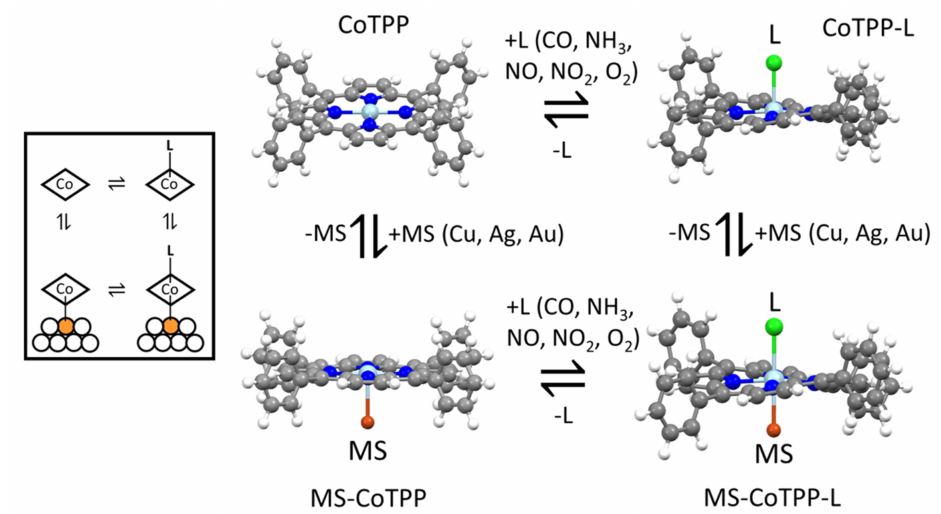
Scheme 1. A schematic representation of the molecular clusters adopted to model the S–CoTPP, the CoTPP–L, and the S–CoTPP–L interactions. Grey, white, blue, light blue, orange, and green spheres represent C, H, N, C, MS, and the whole L molecule, respectively. A schematic sketch of isolated and interacting systems is reported in the